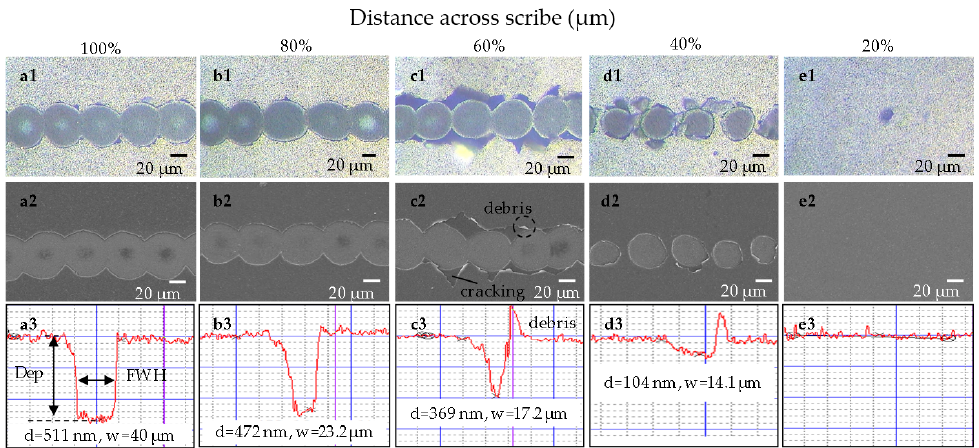
Figure 4. The optical microscope (OM) ( top ) and scanning electron microscope (SEM) ( middle ) images, and depth profiles ( bottom ) for T m = 20%, 40%, 60%, 80% and 100% of a-Si PV modules.